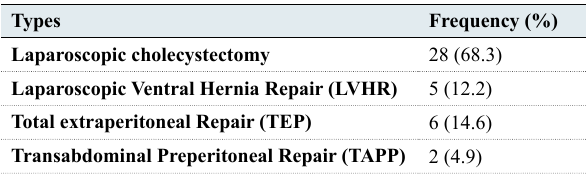
Table 2: Types of Surgical Procedure among the study population (n=41) Types